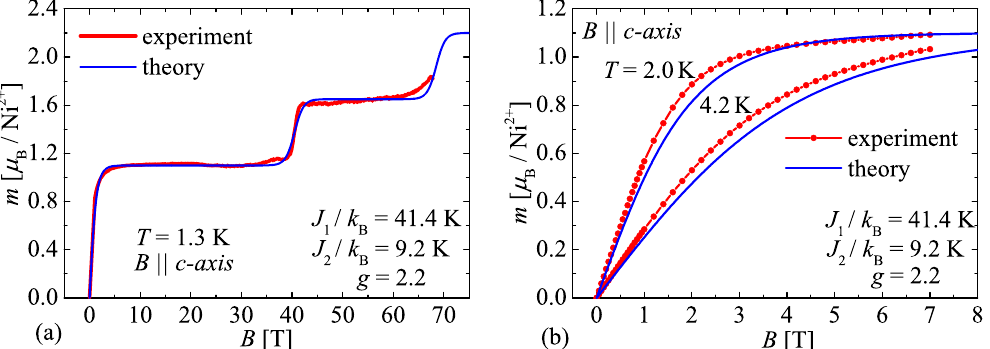
Figure 8. ( a ) high-field magnetization curve (red thick line) of the nickel complex {Ni 4 } recorded in pulsed magnetic fields up to 68 T at the sufficiently low temperature 1.3 K and the respective theoretical fit (thin blue line) based on the spin-1 Heisenberg diamond cluster with the coupling constants J 1 / k B = 41.4 K, J 2 / k B = 9.2 K and the gyromagnetic factor g = 2.2; ( b ) magnetization curves (red lines with filled circles) of the nickel complex {Ni 4 } in static magnetic fields up to 7 T at two different temperatures 2.0 K and 4.2 K versus the respective theoretical predictions (blue lines) for the spin-1 Heisenberg diamond cluster with the same set of the model parameters as specified in ( a